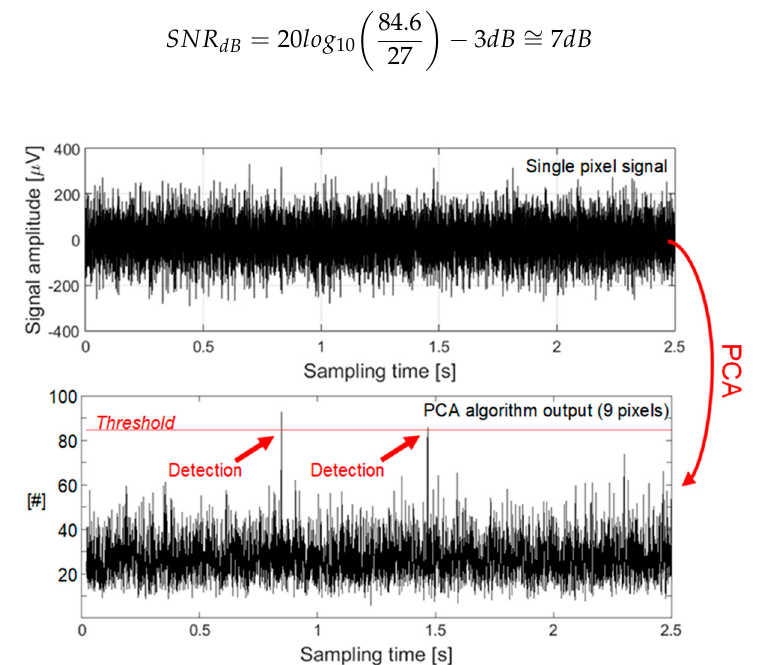
Figure 6. PCA output (left side of Equation (1)) compared with threshold.